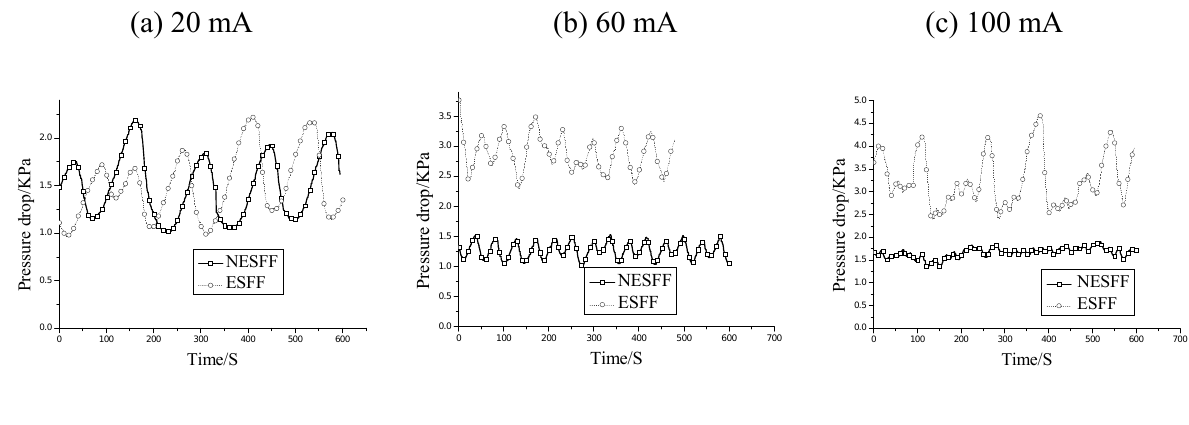
Figure 6. Pressure drops of ESFF and NESFF at different